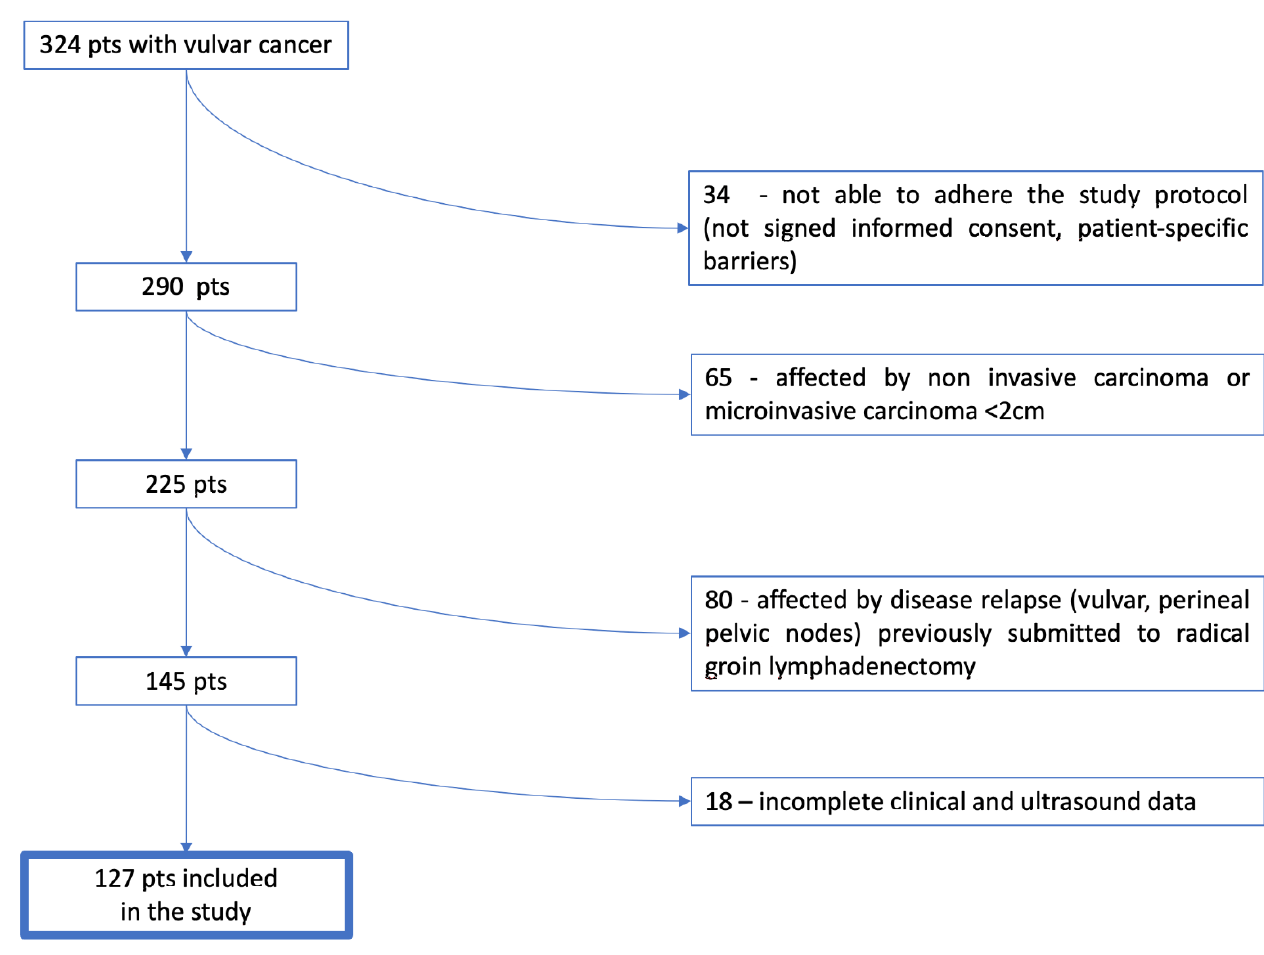
Figure 3. Flow chart: patients’ selection.